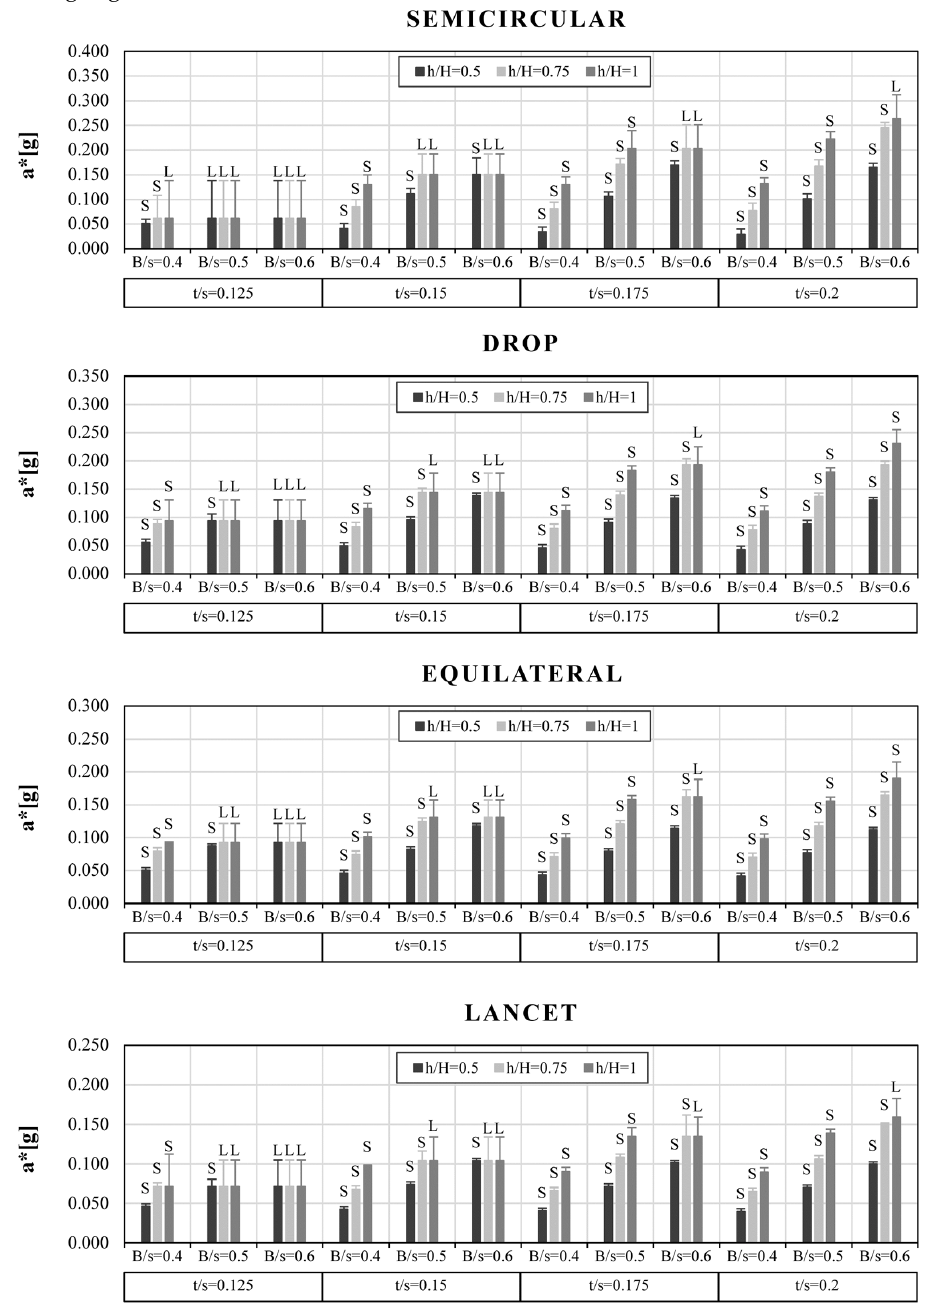
Figure 17. Values of a *[g] of (RI) buttressed arches, for each considered eccentricity, t/s ratio, h/H configuration and B/s value. Local mechanism (L) or Semi-global mechanism (S) are highlighted.